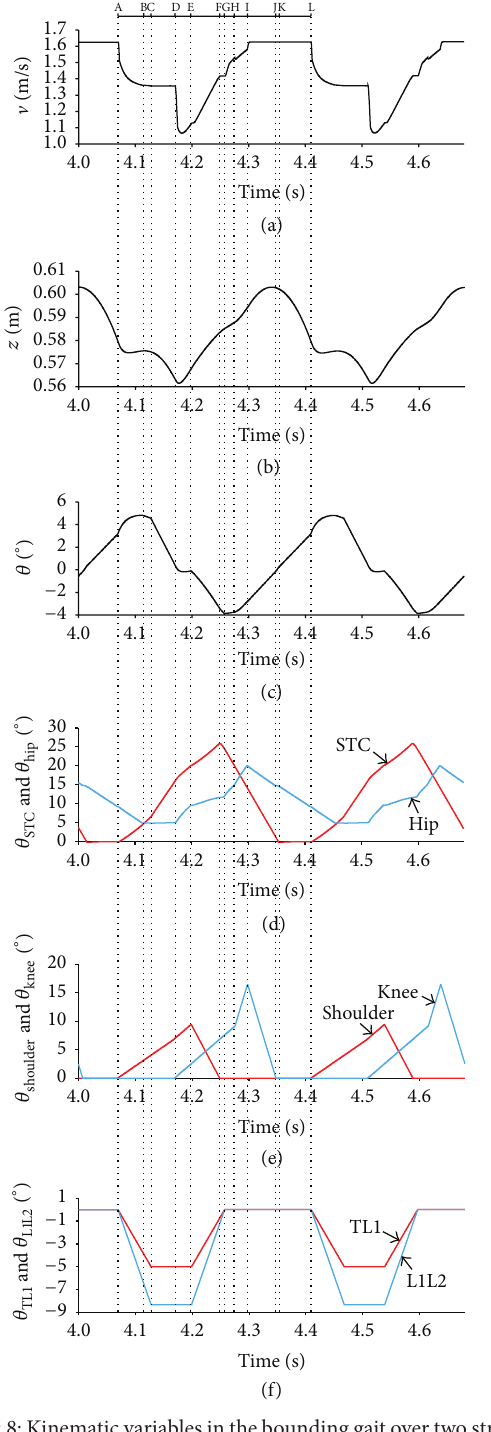
Figure 8: Kinematic variables in the bounding gait over two strides. EV A: Touch-down of fore-limbs. EV B: Transition of hind-limbs from Swing to Hold. EV C: Minimum limitation of the spine joints. EV D: Touch-down of hind-limbs & Transition of fore-limbs from Stance to Thrust. EV E: Lift-off of fore-limbs. EV F: Transition of fore-limbs from Free to Swing. EV G: Maximum limitation of the spine joints. EV H: Transition of hind-limbs from Stance to Thrust. EVI:Lift-offofhind-limbs.EVJ:Transitionofhind-limbsfromFree to Swing. EV K: Transition of fore-limbs from Swing to Hold. EV L: Touch-down of the fore-limbs in the next stride.